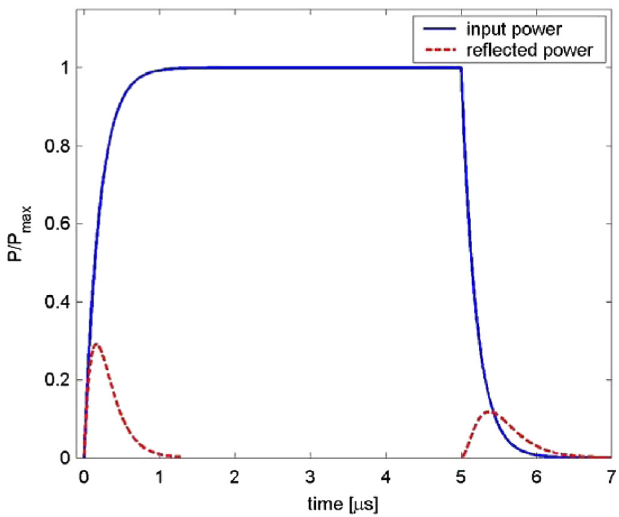
FIG. 5. (Color) Time domain cavity response to a step input in case of (cid:4) ¼ 1 (blue: rf input pulse; red: cavity reflected